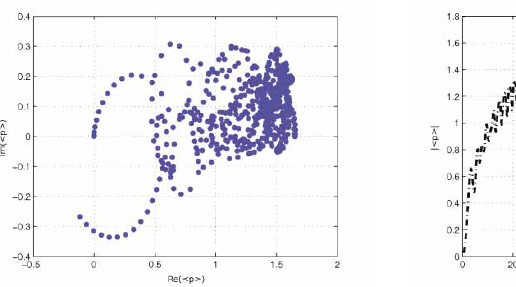
Figure 18. Distribution Re( (cid:5) p (cid:6) ), Im( (cid:5) p (cid:6) ) (old), L = 113 . 7, N = 268.